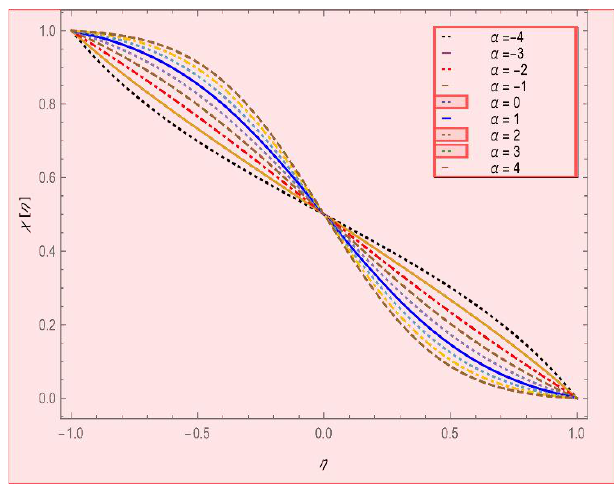
Figure 3. Concentration profiles for 𝜑 1 = 𝜑 2 = 0.01, 𝑆𝑐 = 1, 𝑀 = 1, 𝑅𝑒 = −1,𝑃𝑟 = 6.2 .